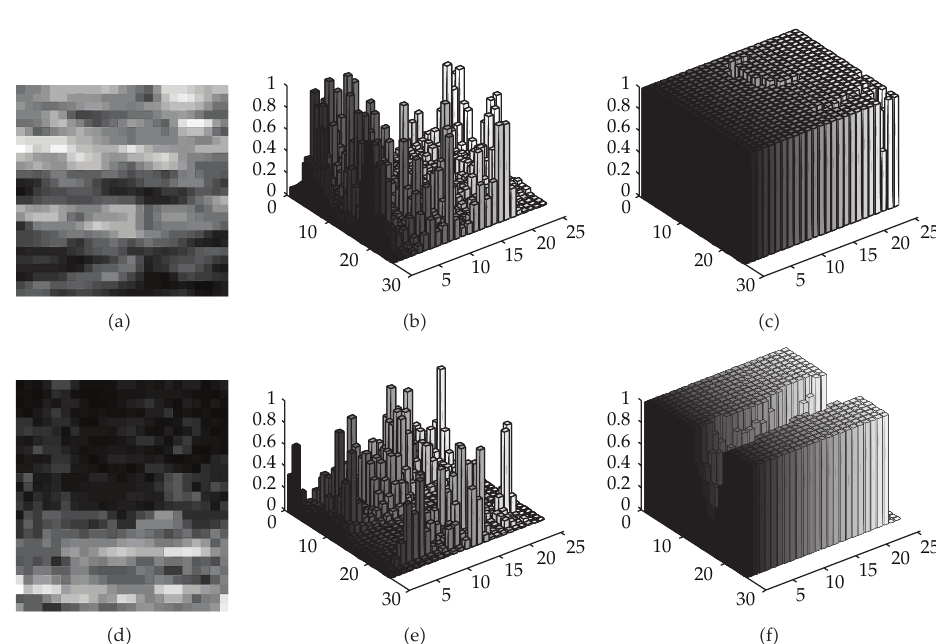
Figure 3: Comparison between gradient-based ESF and phase-based ESF of the US image. (cid:3) a (cid:4) Speckled homogeneous image; (cid:3) b (cid:4) and (cid:3) c (cid:4) are the gradient-based ESF and phase-based ESF of (cid:3) a (cid:4) ; (cid:3) d (cid:4) Speckled image with contour; (cid:3) e (cid:4) and (cid:3) f (cid:4) are the gradient-based ESF and phase-based ESF of (cid:3) d (cid:4)